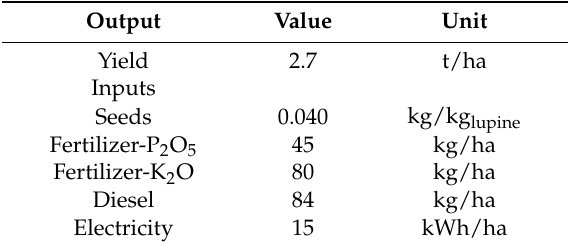
Table 2. Inventory data for agricultural phase of lupine grain production [23].